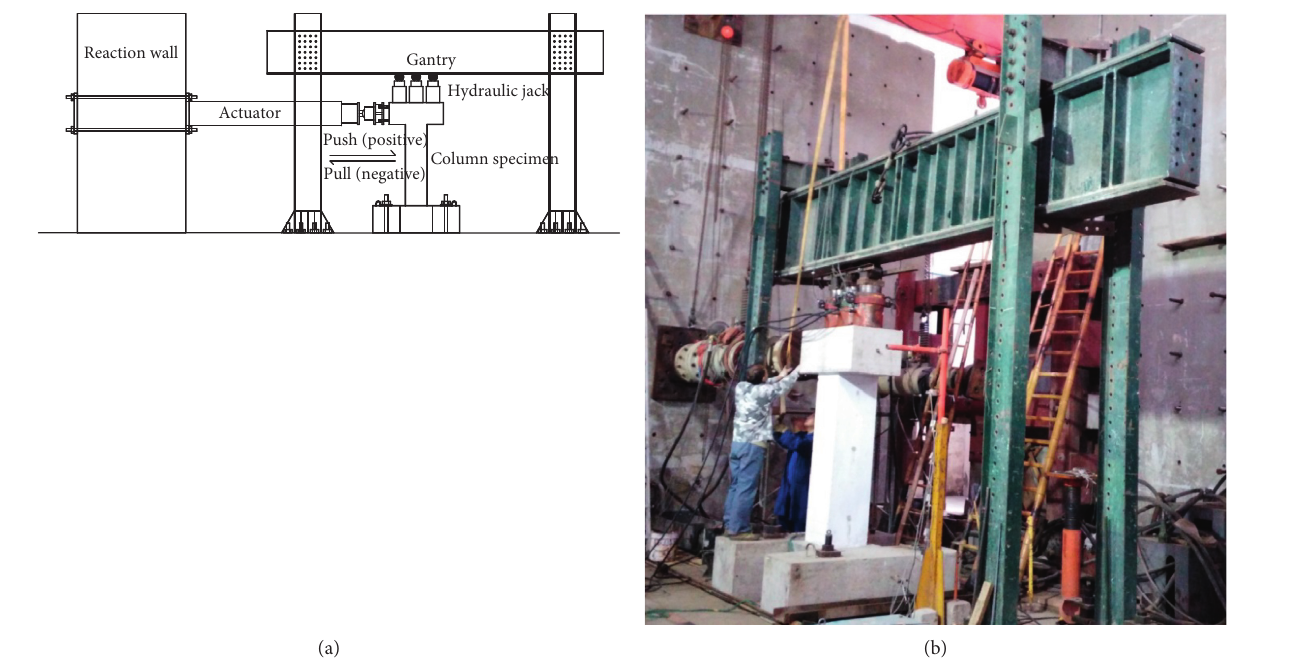
Figure 5: Loading device and specimen setup. (a) Schematic diagram. (b) Picture.